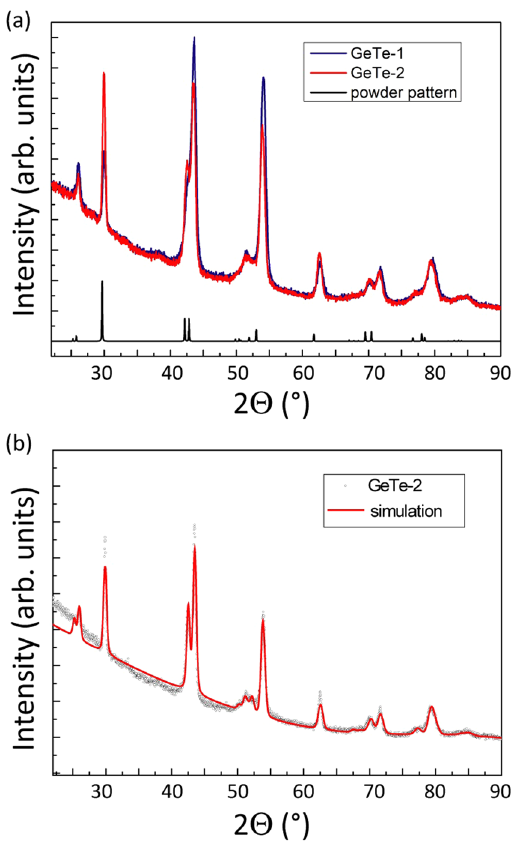
Figure 2. ( a ) GIXRD spectra of GeTe-1 and GeTe-2 samples after thermal annealing above the amorphous- to-crystalline phase transition. ( b ) Fitting of the GeTe-2 crystallized sample with the pattern expected for the rhombohedral R3m:H structure of